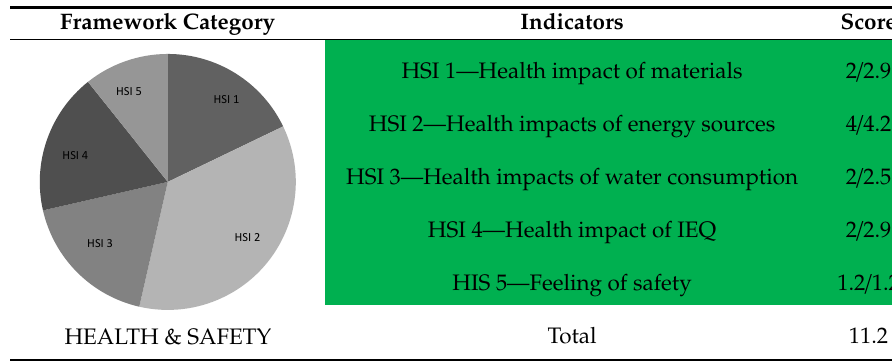
Table 12. RAG rating of Health and Safety Indicator in Louroujina.